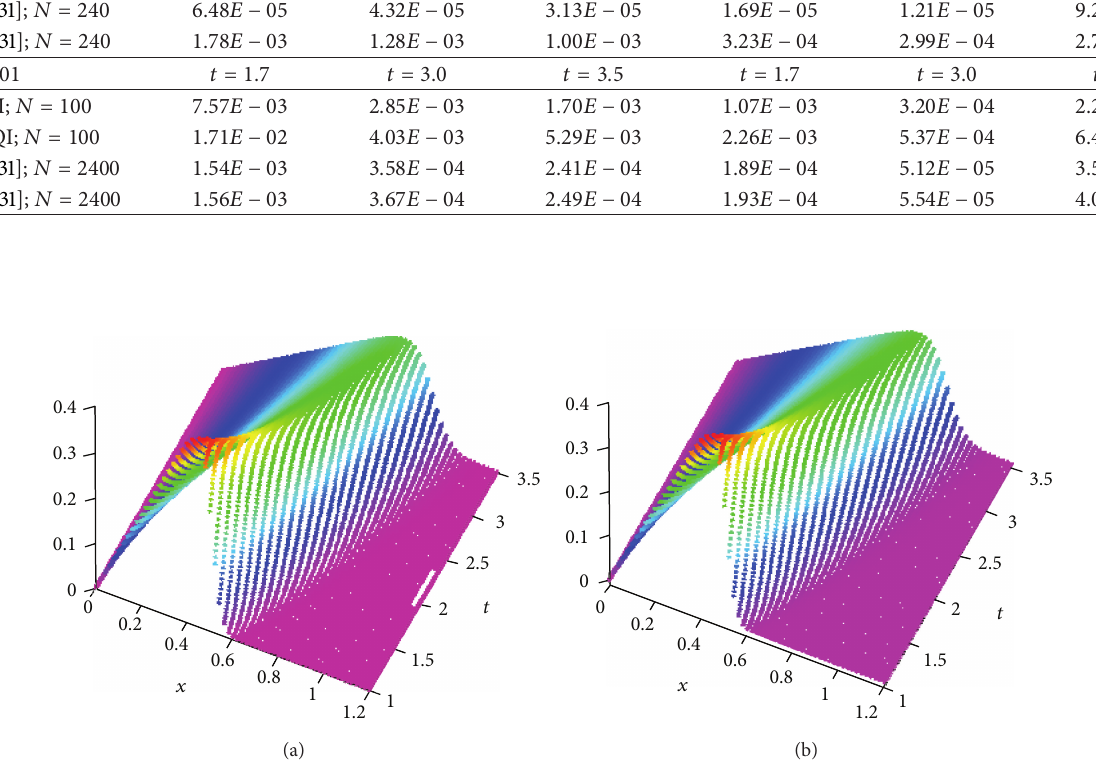
The 𝐿 2 and 𝐿 ∞ errors of IMQQI scheme are calculated in 1000 points for 𝑘 1 = 1 , 𝑘 2 = −1 , Δ𝑡 = 0.001 , and 𝑐 =